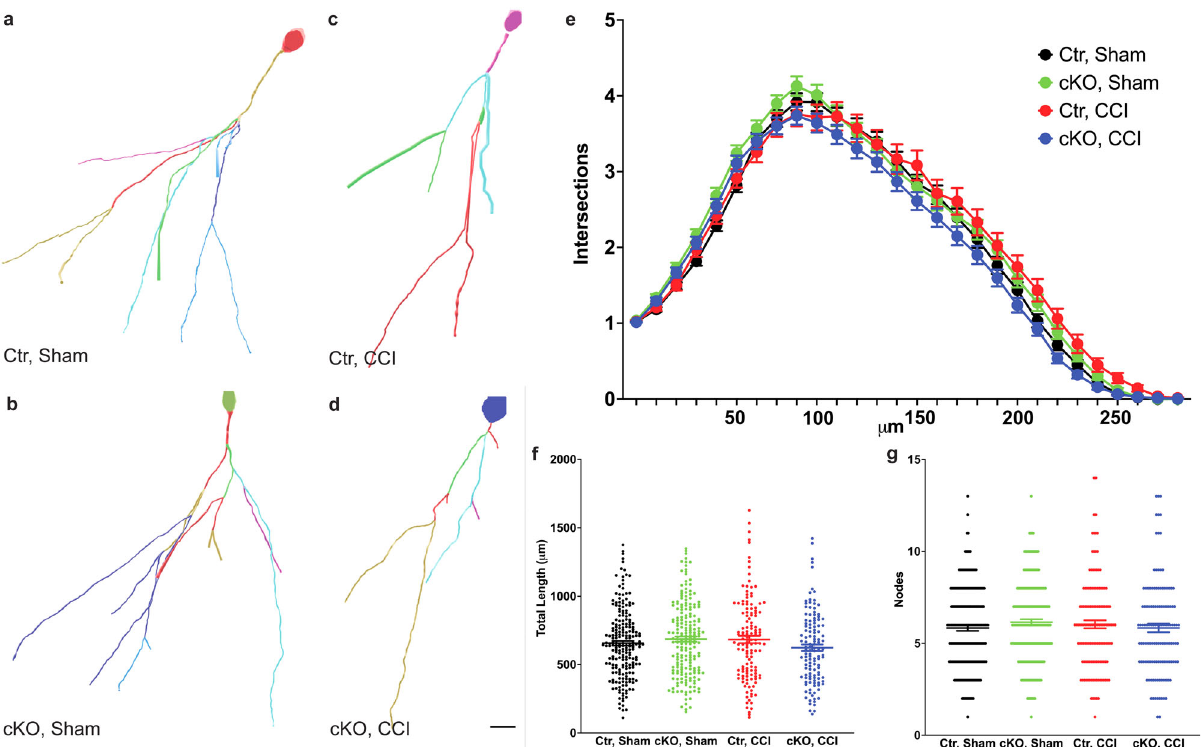
Fig. 4 The reduction in astrocytic ApoE impairs dendritic complexity in newborn neurons in the injured dentate gyrus. a – d Reconstructed dendritic trees of newborn neurons 4 weeks after being injected with a GFP-expressing retrovirus in the dentate gyrus. e Neither the reduction of astrocytic ApoE nor CCI results in de fi cits in dendrites of newborn neurons in the dentate gyrus. f , g Similar observations were seen in the total length and nodes in the newborn neurons. Scale bar in ( d ) = 10 µ m.